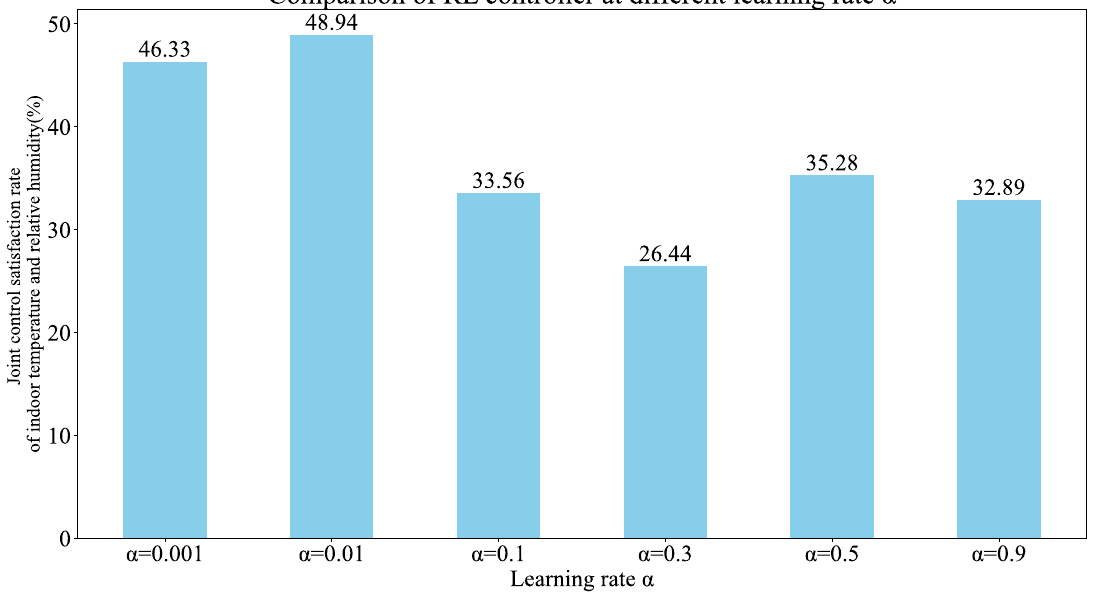
Figure 13. Comparison of the RL controller at different learning rates.